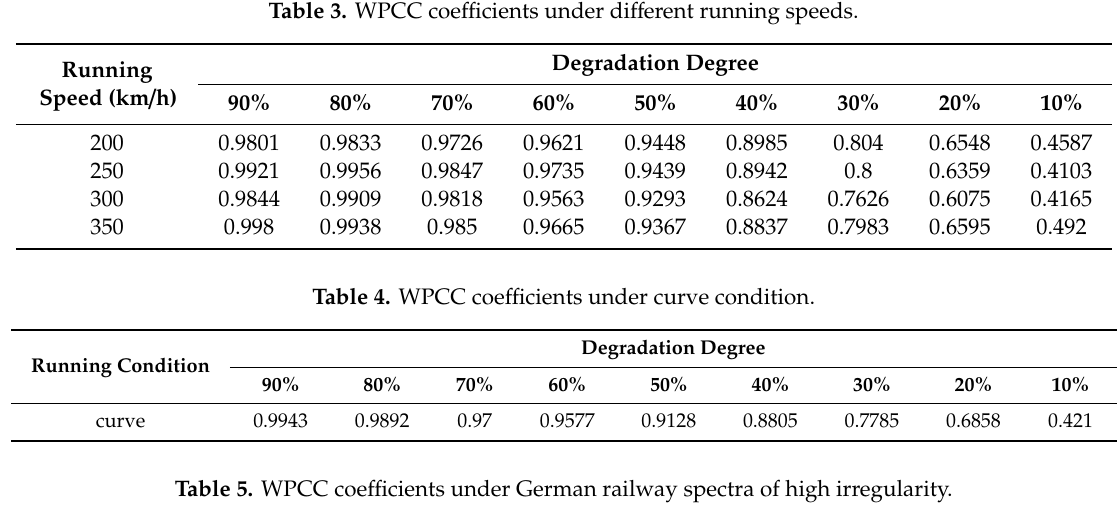
Table 3. WPCC coe ffi cients under di ff erent running speeds.